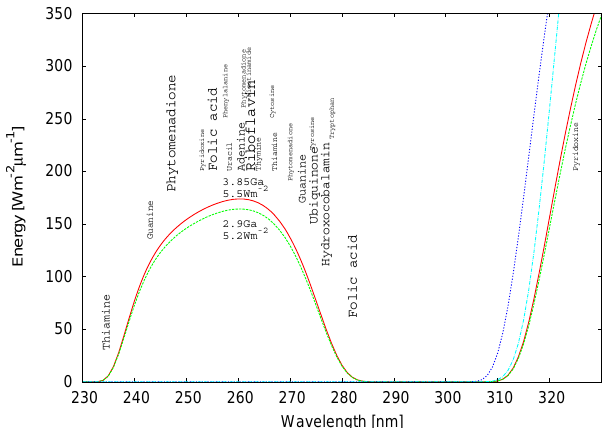
Figure 3. The wavelengths of maximum absorption of many of the fundamental molecules of life (common to all three domains) co- incide with the predicted solar spectrum at Earth’s surface in the UV-C at the time of the origin of life at 3.85Ga and until at least 2.7Ga. The font size of the letter roughly indicates the relative size of the absorption cross section of the indicated